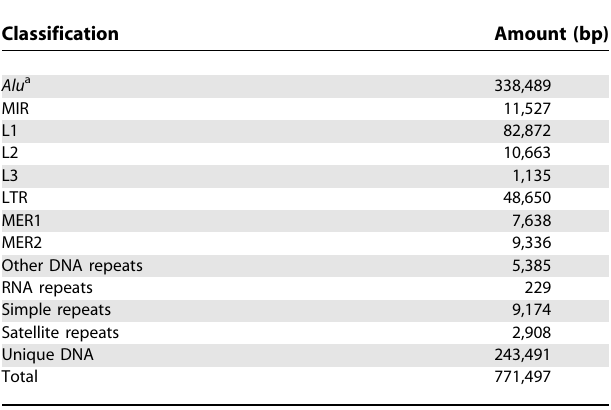
Table 2. Classification of Genomic DNA Deleted by ARMDs in Chimpanzee